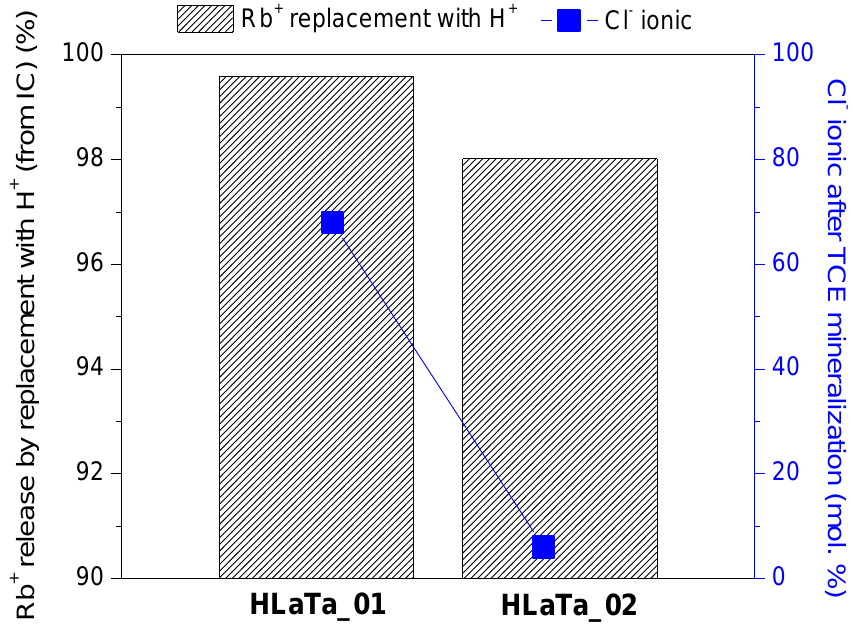
Figure 14. Dependence of proton exchange degree measured by ion chromatography with the amount of Cl − obtained after the mineralization of TCE over HLaTa_01(02) catalysts.